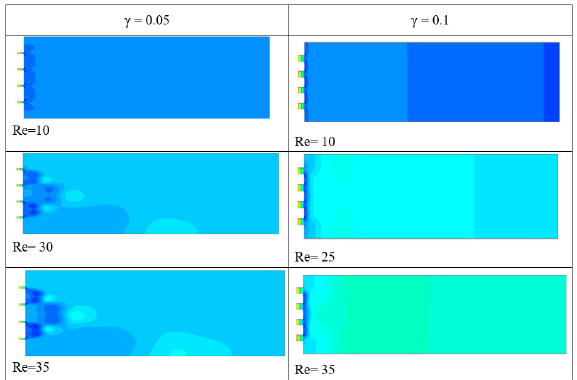
Figure 12: The pressure of flow for γ = 0.05, 0.1 in different Reynolds numbers for four